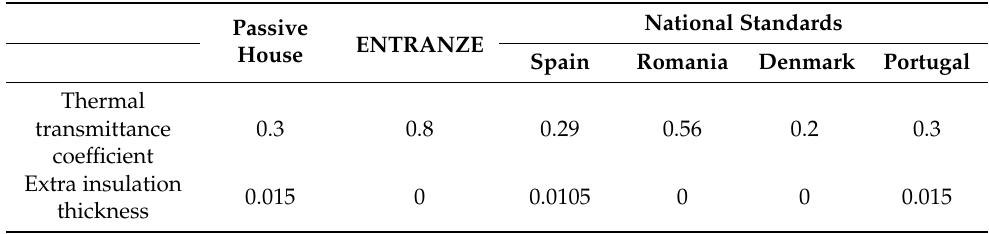
Table 15. Results of the study